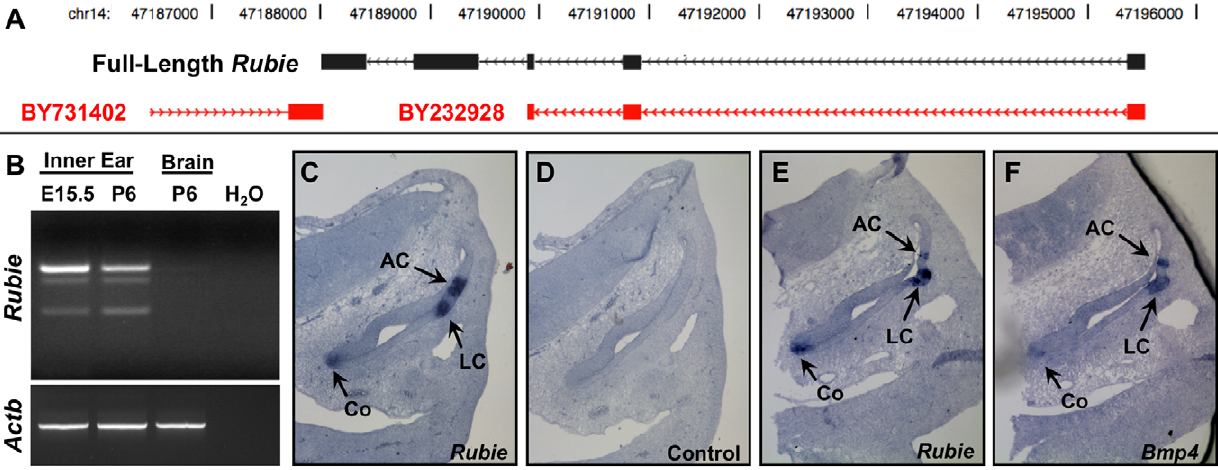
Figure 3. Sequence and expression analysis of Rubie . (A) Rubie (EST BY232928) sequence displayed in genomic databases is derived from a partially-sequenced RIKEN cDNA clone and includes 388 bp, divided among three exons. Resequencing of the RIKEN clone revealed a full-length insert of 1404 bp, divided among five exons. (B) Expression of Rubie in embryonic (E15.5) and postnatal (P6) mouse inner ears was confirmed by RT- PCR. Expression was not observed in P6 hindbrain. The bottom PCR band represents use of an alternative splice site between exons 1 and 2 of Rubie . (C) Rubie expression was detected in the three sensory cristae (anterior crista, AC; lateral crista, LC; posterior crista, not shown) and the developing cochlea (Co) of sectioned E11.5 embryos by in situ hybridization. (D) No signal was detected using a Rubie sense control probe. Rubie (E) and Bmp4 (F) exhibited similar expression patterns in the developing inner ear.